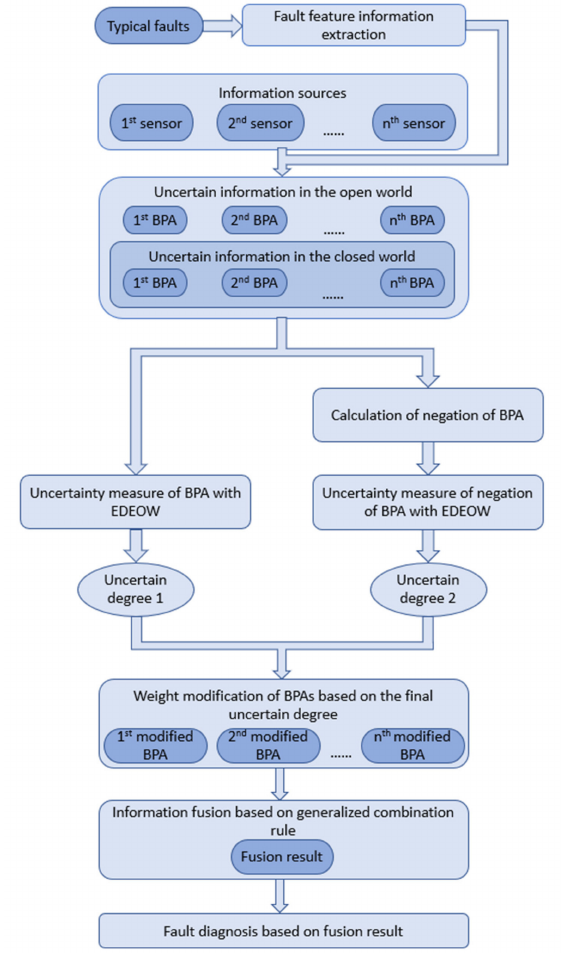
Figure 1. The proposed data fusion method based on EDEOW, negation of BPA, and